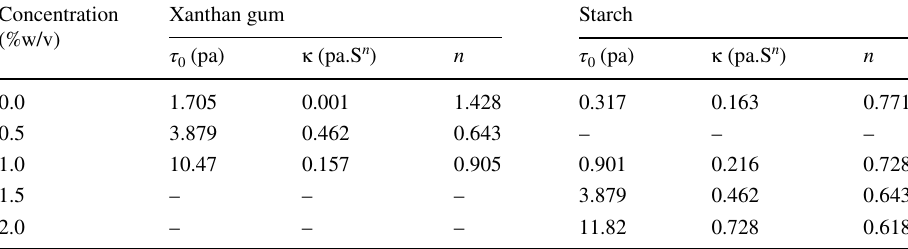
Table 9 Rheological properties at different polymer